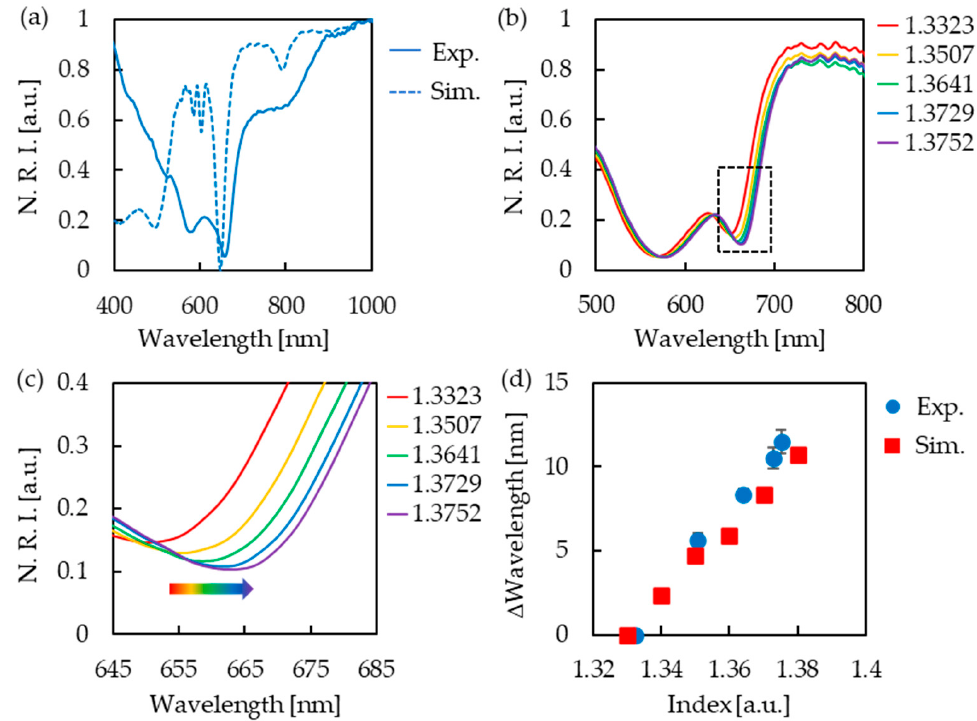
Figure 3. ( a ) Reflection spectra of experiments (solid lines) and simulations (dashed lines). The vertical axis shows normalized reflection intensity (N. R. I.). ( b ) Reflection spectra of gold nanostructures in various refractive index solutions (water/2-propanol mixture). ( c ) Enlarged figure of absorption peak in ( b ) (dotted square part). The peak wavelength was red-shifted with the increasing refractive index. ( d ) Comparison of experimental and simulated peak shift.